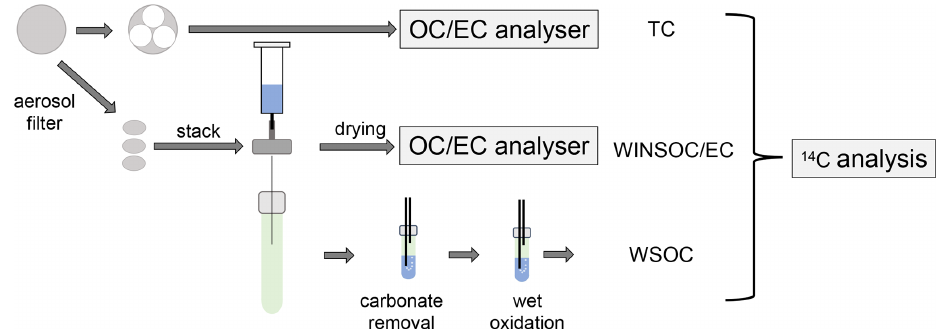
Figure 1. Separation of the different fractions for 14 C analysis starting from the aerosol filters. One or multiple circular quartz fibre filter punches are stacked and intercalated in the water extraction setup. The residual filter material is used for WINSOC and EC analysis after drying, and the extract is oxidised by chemical wet oxidation. The remaining filter material is used for TC